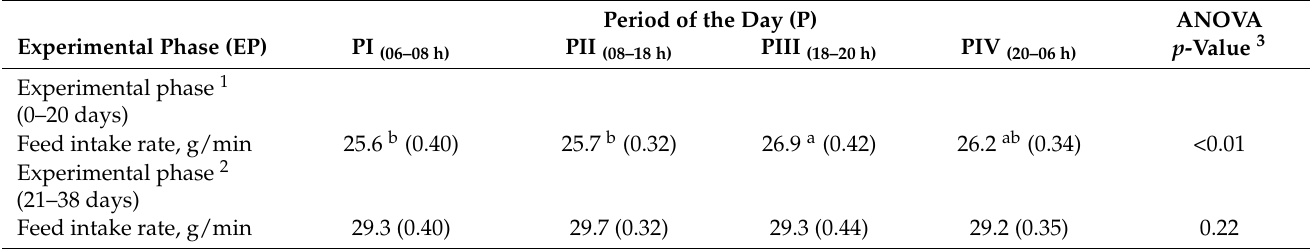
Table 2. Feed intake rate of finishing pigs according to the period of the day in each experimental phase 1,2